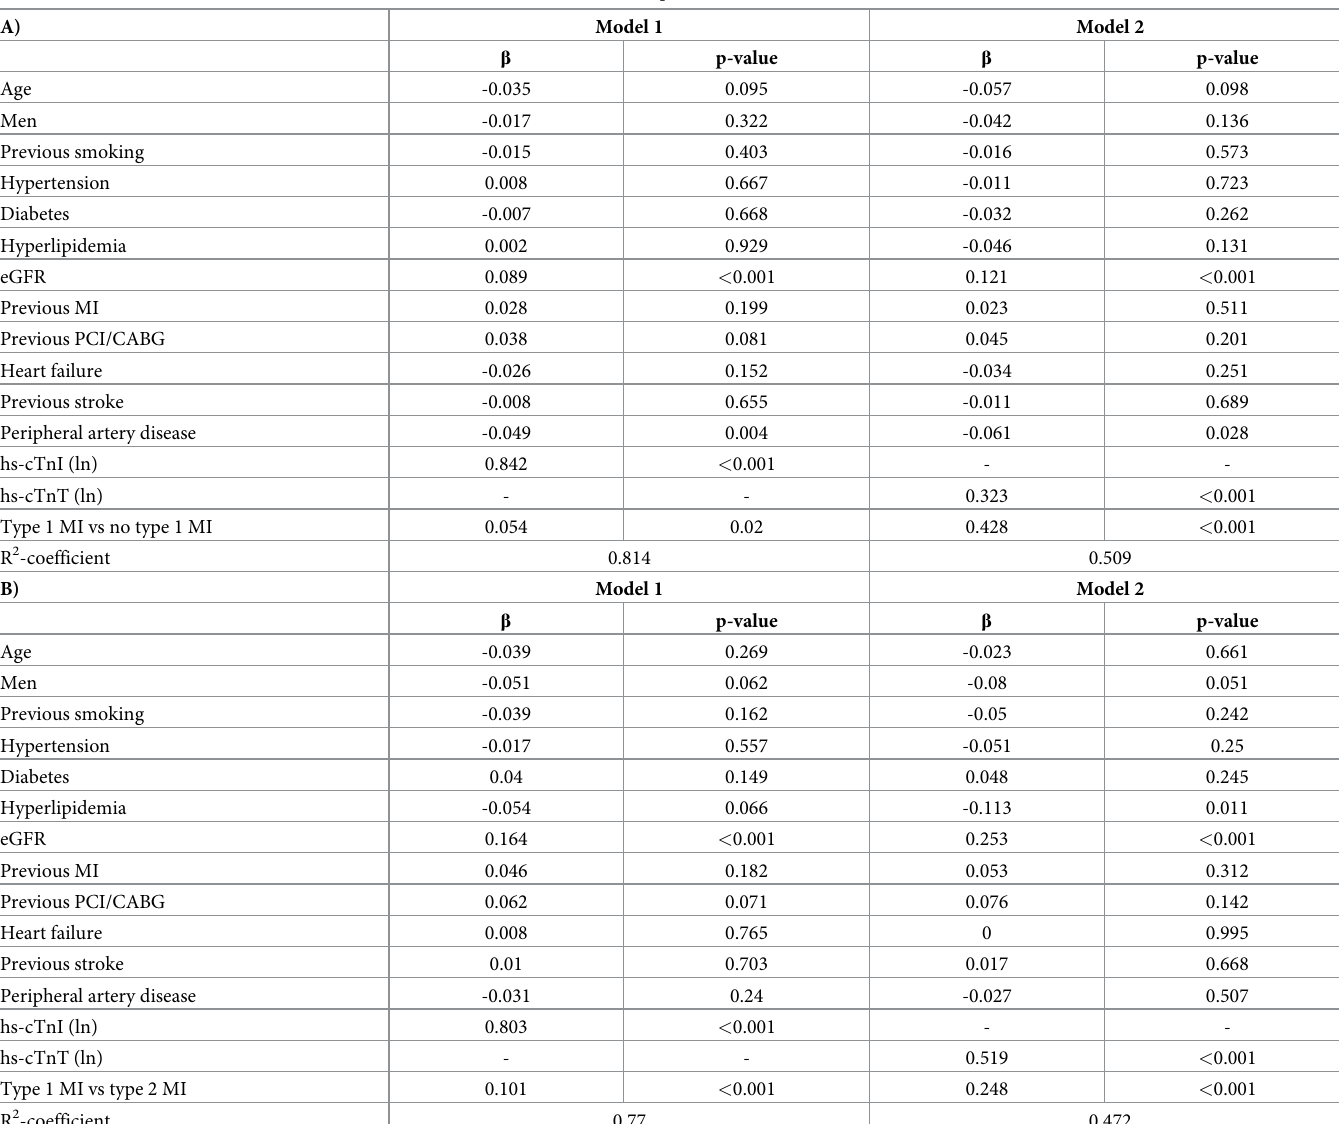
Table 3. Predictors of the hs-cTn I/T ratio (ln). A) Total cohort (n = 702); B) MI patients (n =